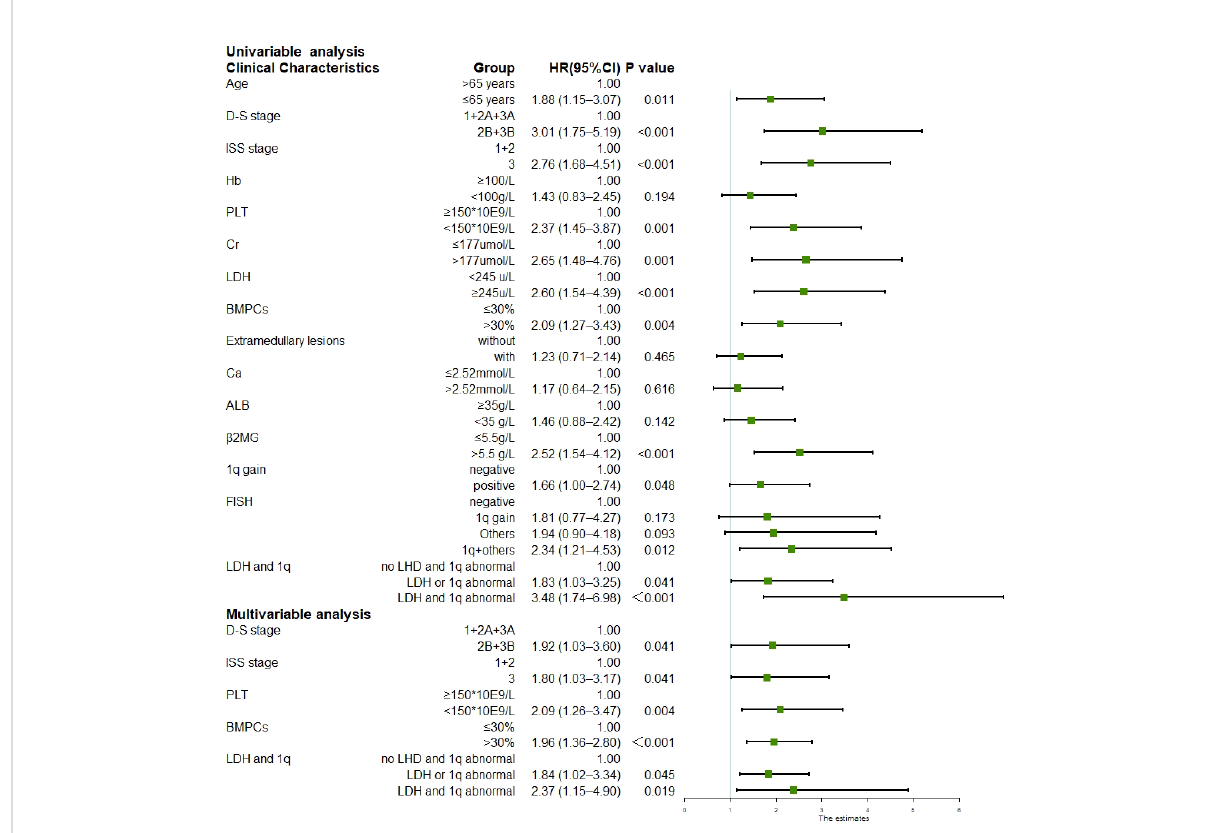
FIGURE 2 Univariable and multivariable analysis for overall survival (Data can be found in Supplementary Table